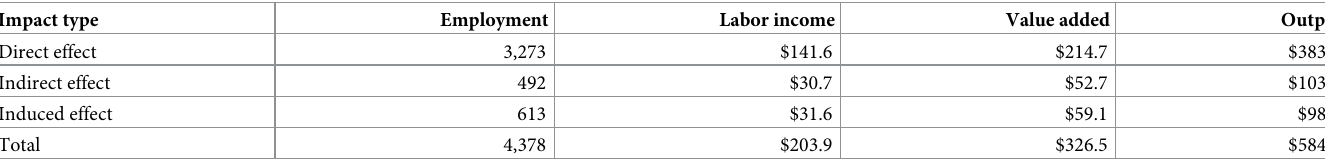
Table 4. Economic impacts of bird tourism in Alaska, 2021 US$